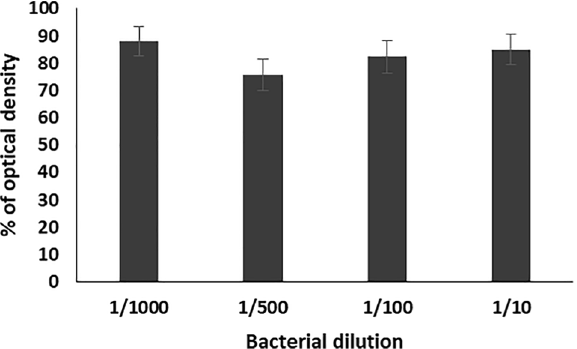
Figure 5. Percentage of the formed biofilms of 17 enterococcal isolates, prepared in different dilutions (1/10, 1/100, 1/500, and 1/1000) from bacterial suspension adjusted to 0.5 MacFarland, after treatment the preformed biofilms with the six bacteriophages (EPA, EPB, EPC, EPD, EPE, EPF) as compared to the control. Each bar represents the mean of three independent measurements.